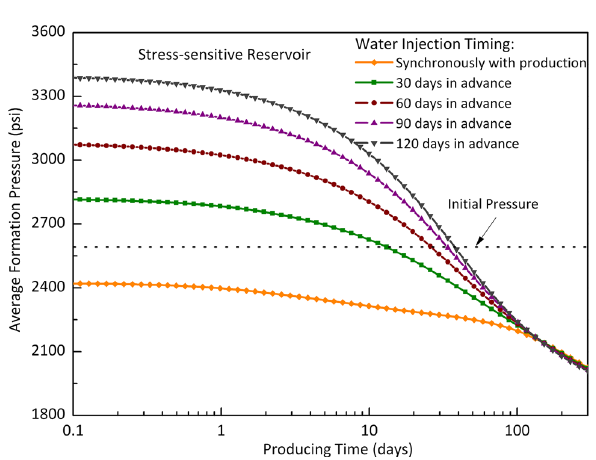
Fig. 13 Average formation pressure under different water injection timing